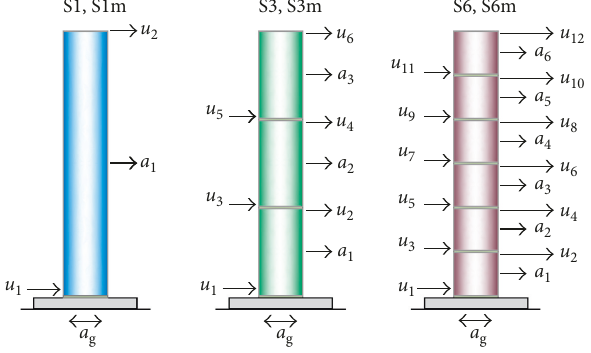
Figure 4: Measured quantities.